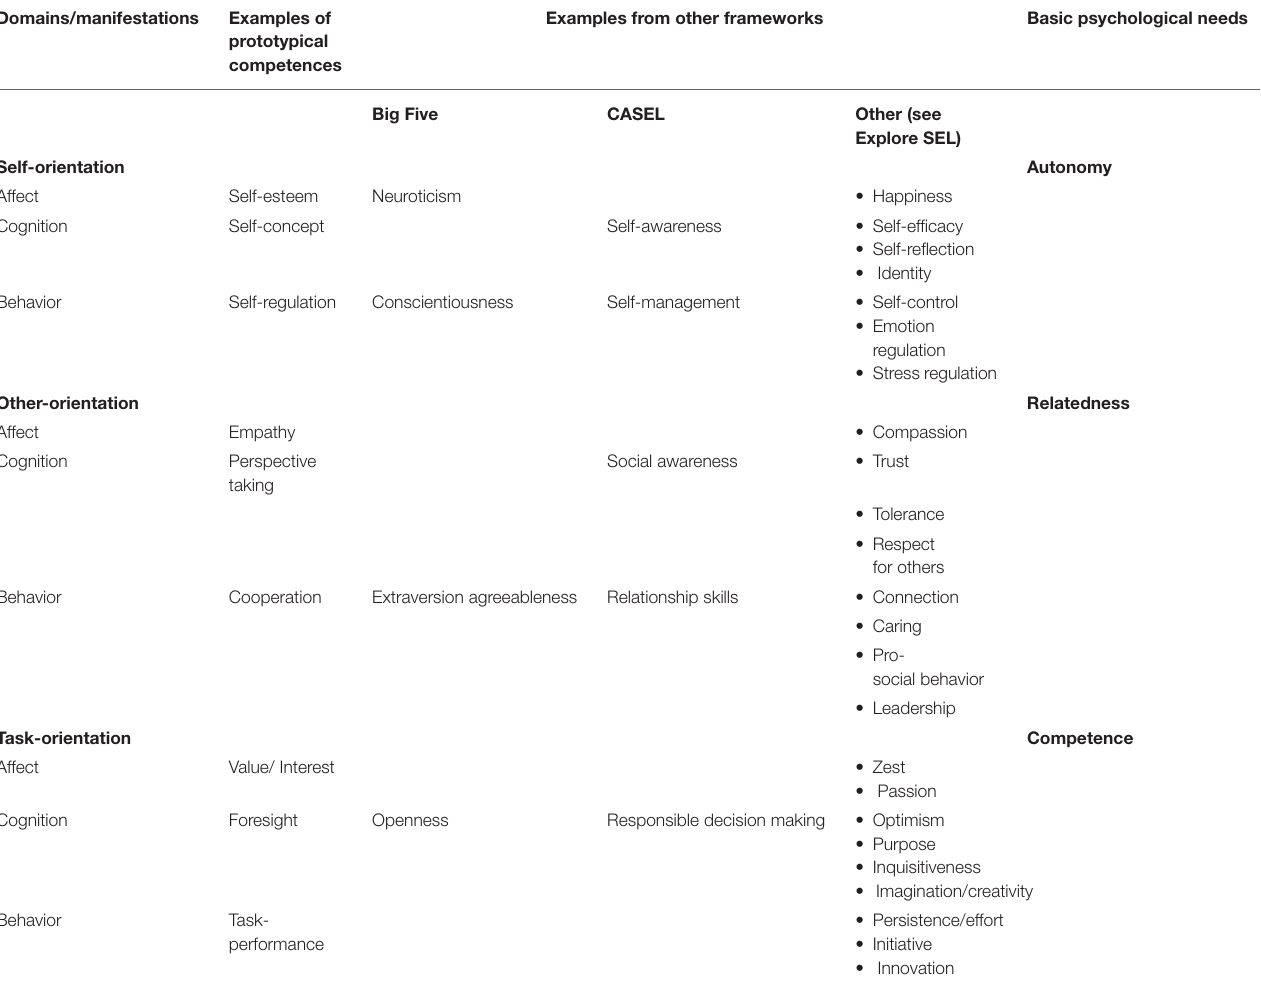
TABLE 1 | Domains and manifestations of socio-emotional competences